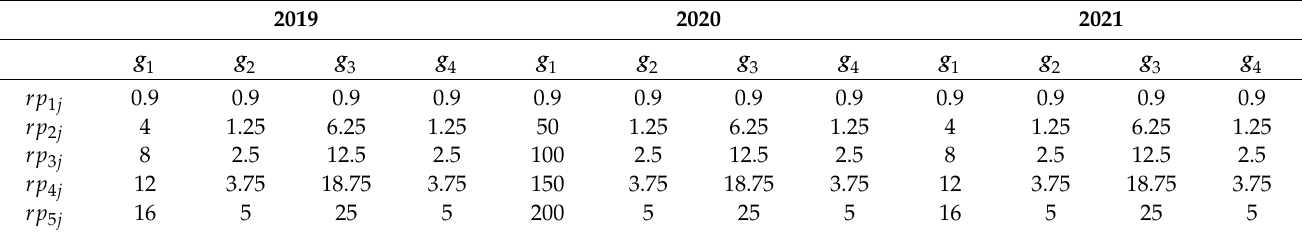
Table A1. Representative points rp lj for 2019, 2020 and